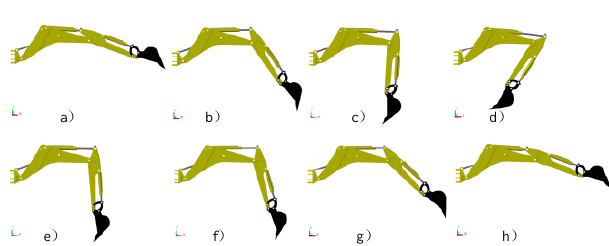
Figure 10. Visualization of the four-quadrant operation of the arm cylinder.